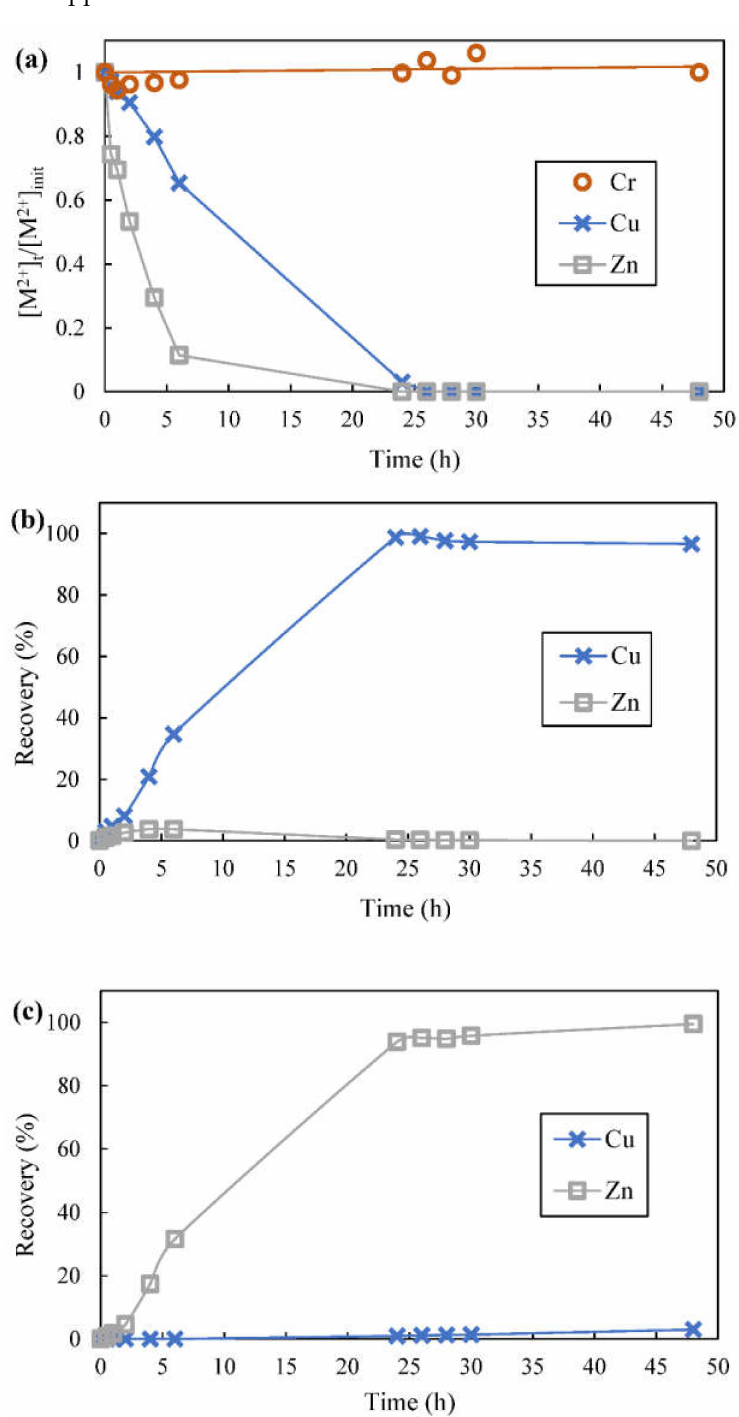
Figure 11. Metal ions transport and recovery using SLM; ( a ) change of metal ions concentration in feed over time, ( b ) recovery of metal ions in the first stripping phase (0.2 mol/L pH 3 citrate buffer) over time, and ( c ) recovery of metal ions in the second stripping phase (1 mol/L sulfuric acid) over